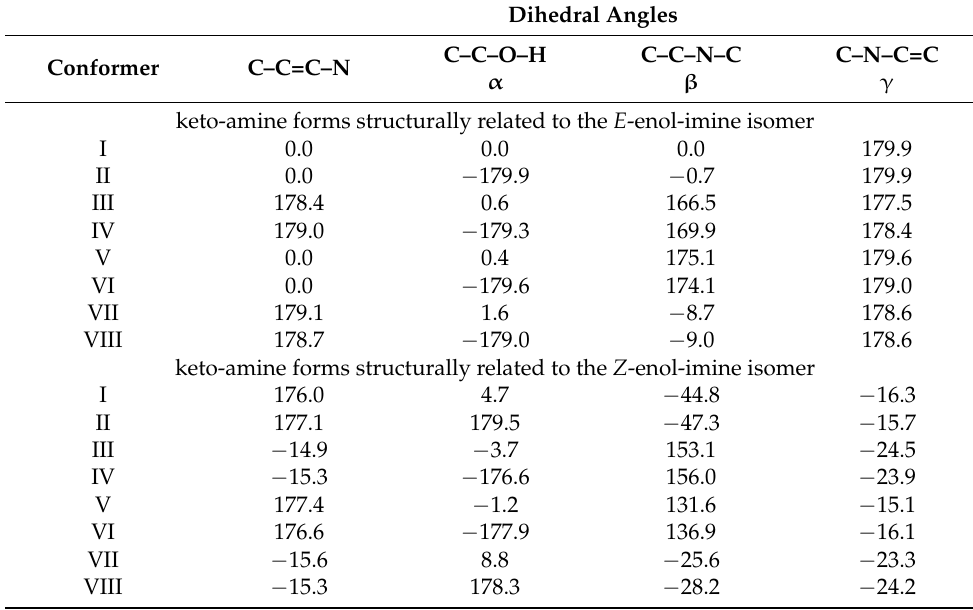
Table 3. B3LYP/6-311++G(d,p) optimized conformationally-relevant dihedral angles of the keto- amine forms of the E - and Z -enol-imine isomers of BHAP a .